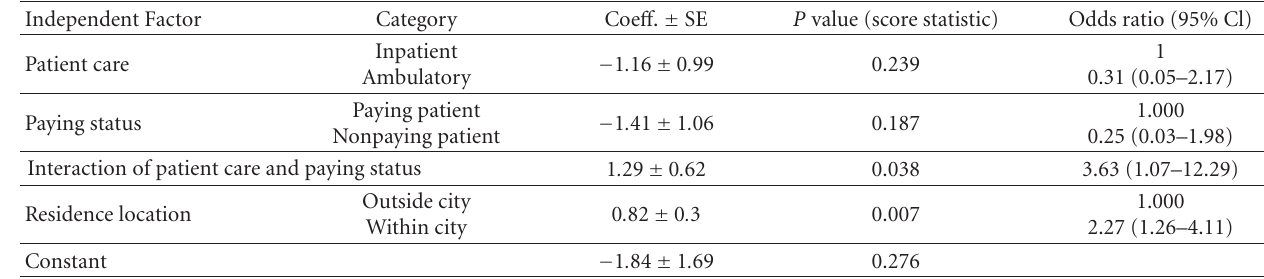
Table 4: Multivariate analysis of factors associated with postcataract endophthalmitis.